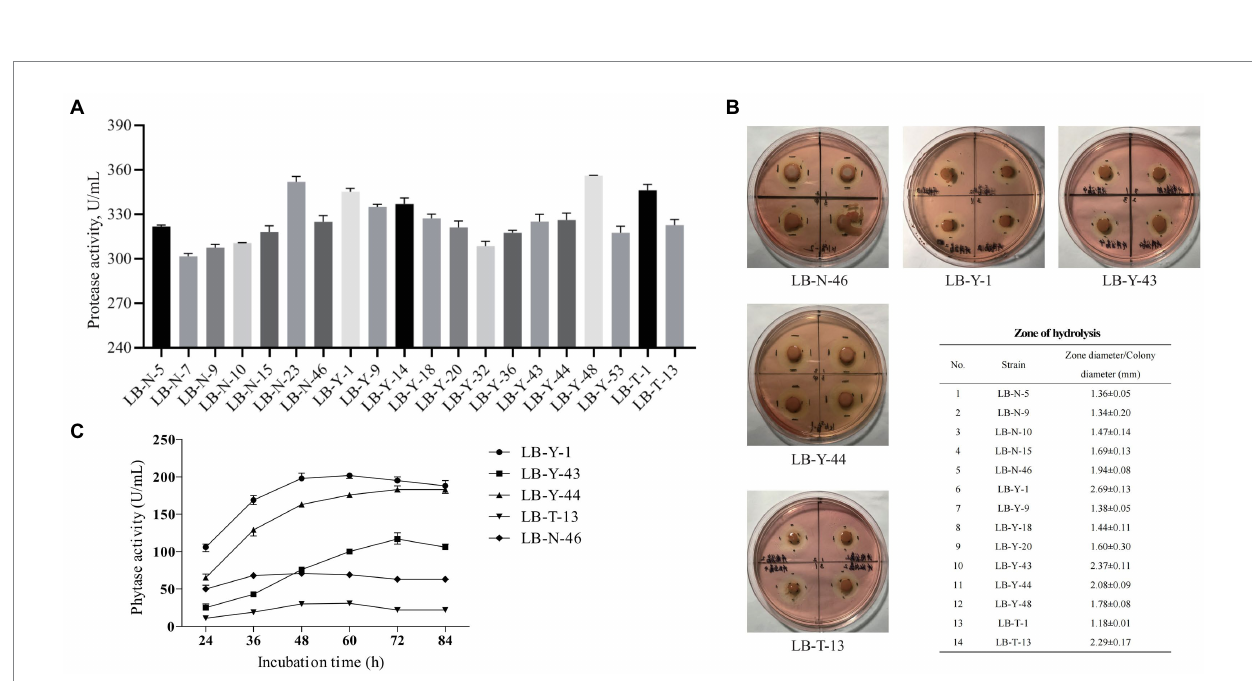
FIGURE 2 The screening process of Bacillus spp. (A) Protease production capacity (Primary Screen). (B) Cellulase production capacity (Secondary Screen). (C) Phytase production capacity (Tertiary Screen). Values are presented as Mean ±